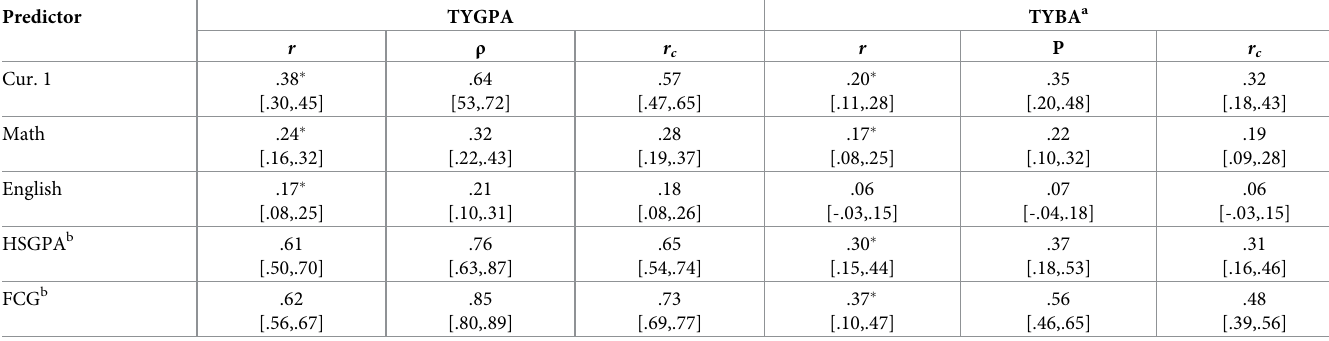
Table 2. Correlations between predictors and third year academic outcomes. Predictor